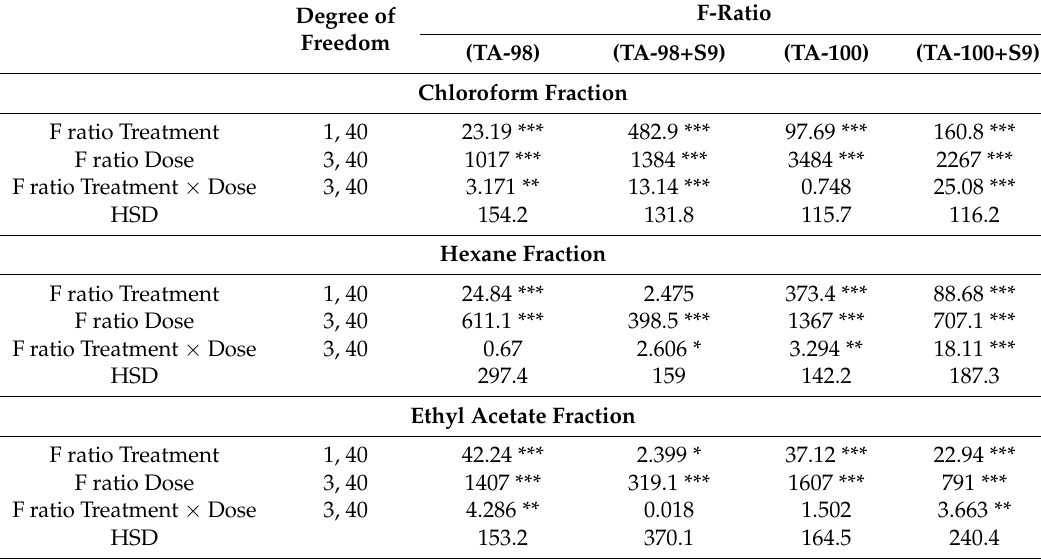
Table 2. The honestly significant difference (HSD) values and F ratio for treatment, dose and, interaction between treatment and dose obtained from 2-way analysis of variance. Degree of